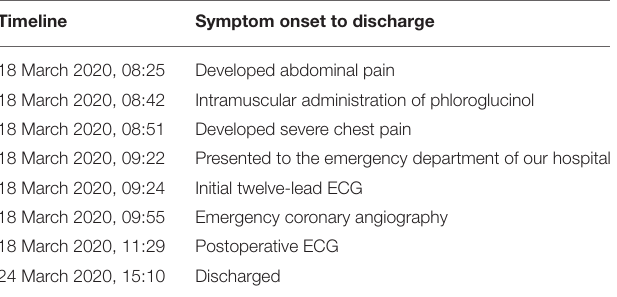
TABLE 1 | Timeline from the onset of symptoms in the patient to discharge is provided.